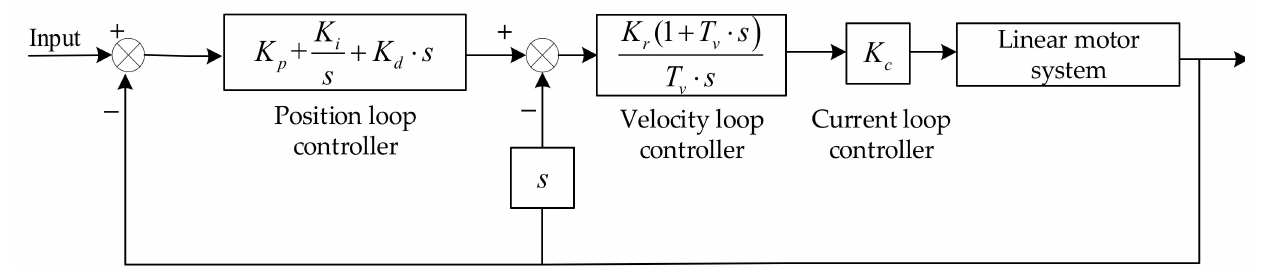
Figure 6. Servo control model of linear motor based on PID control method.